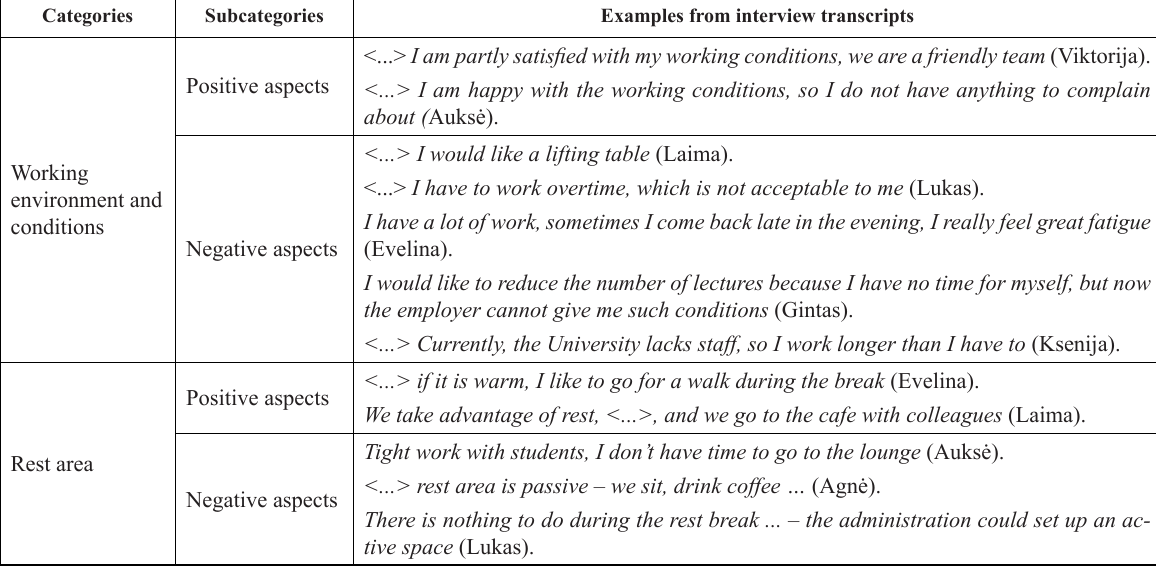
Table 5. Effect of working conditions on physical activity of sedentary adults